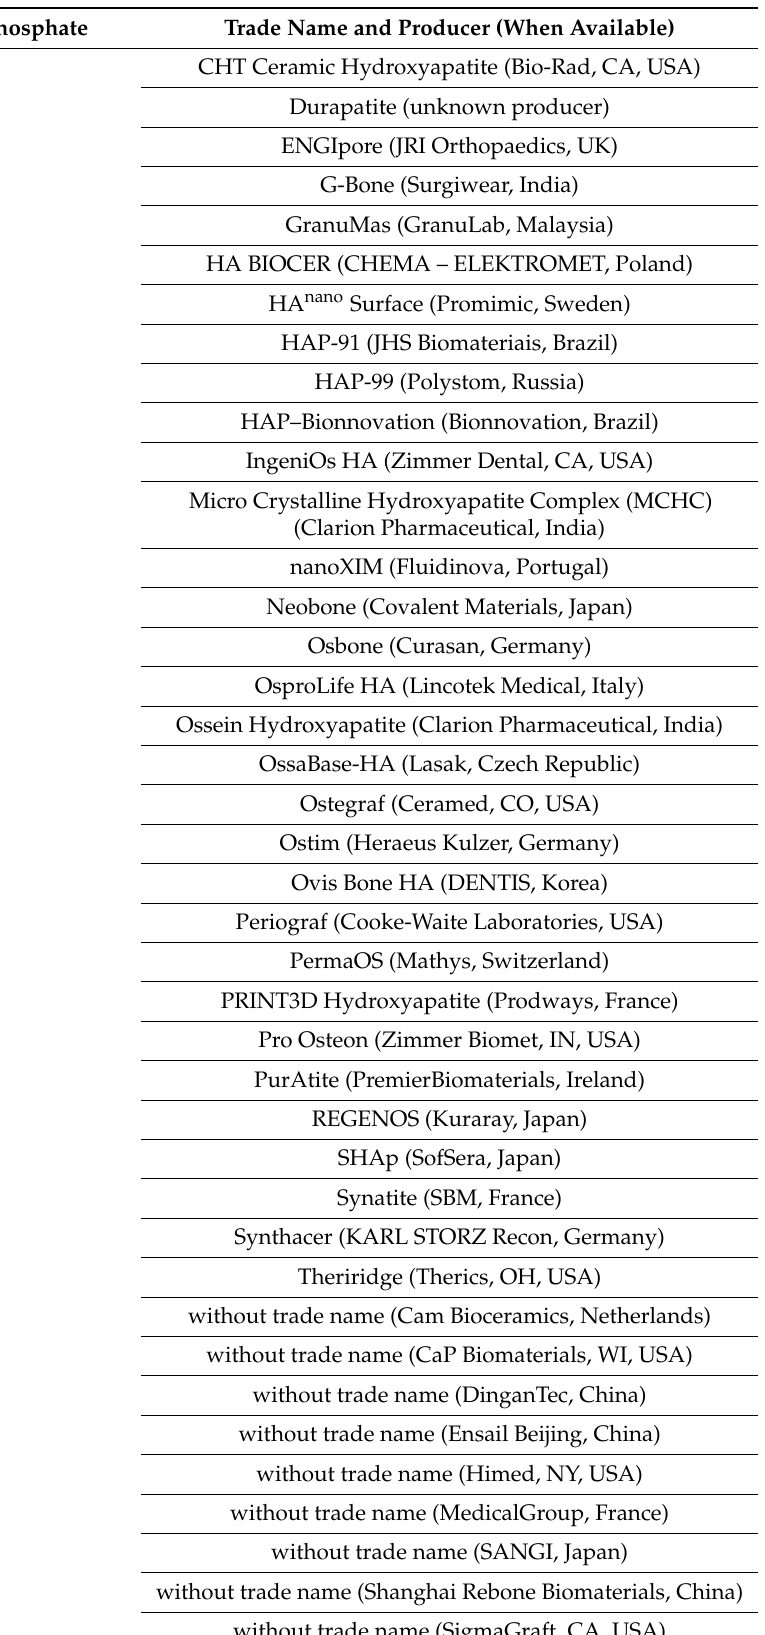
Table 3. Cont . Calcium